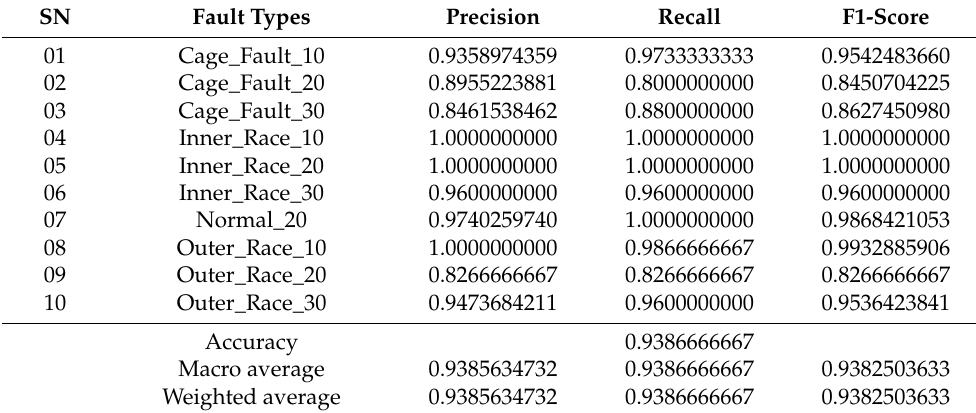
Table 3. Classification report of PSO-SVM classifier.